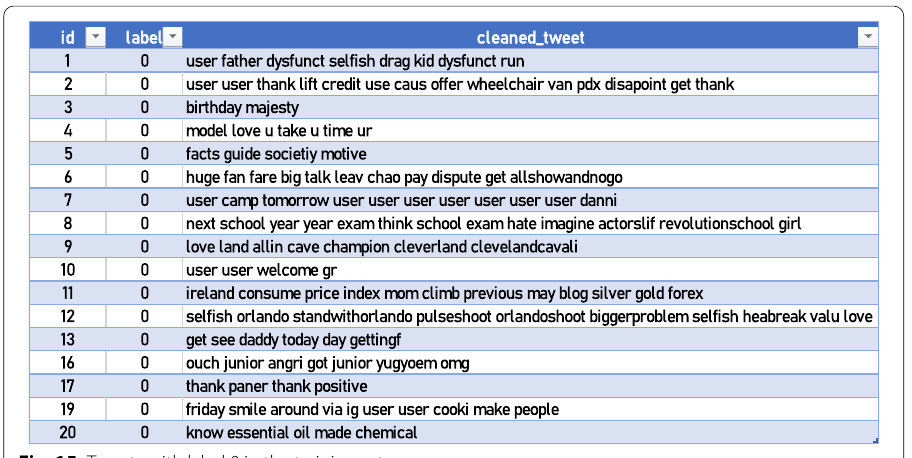
Fig. 15 Tweets with label 0 in the training set